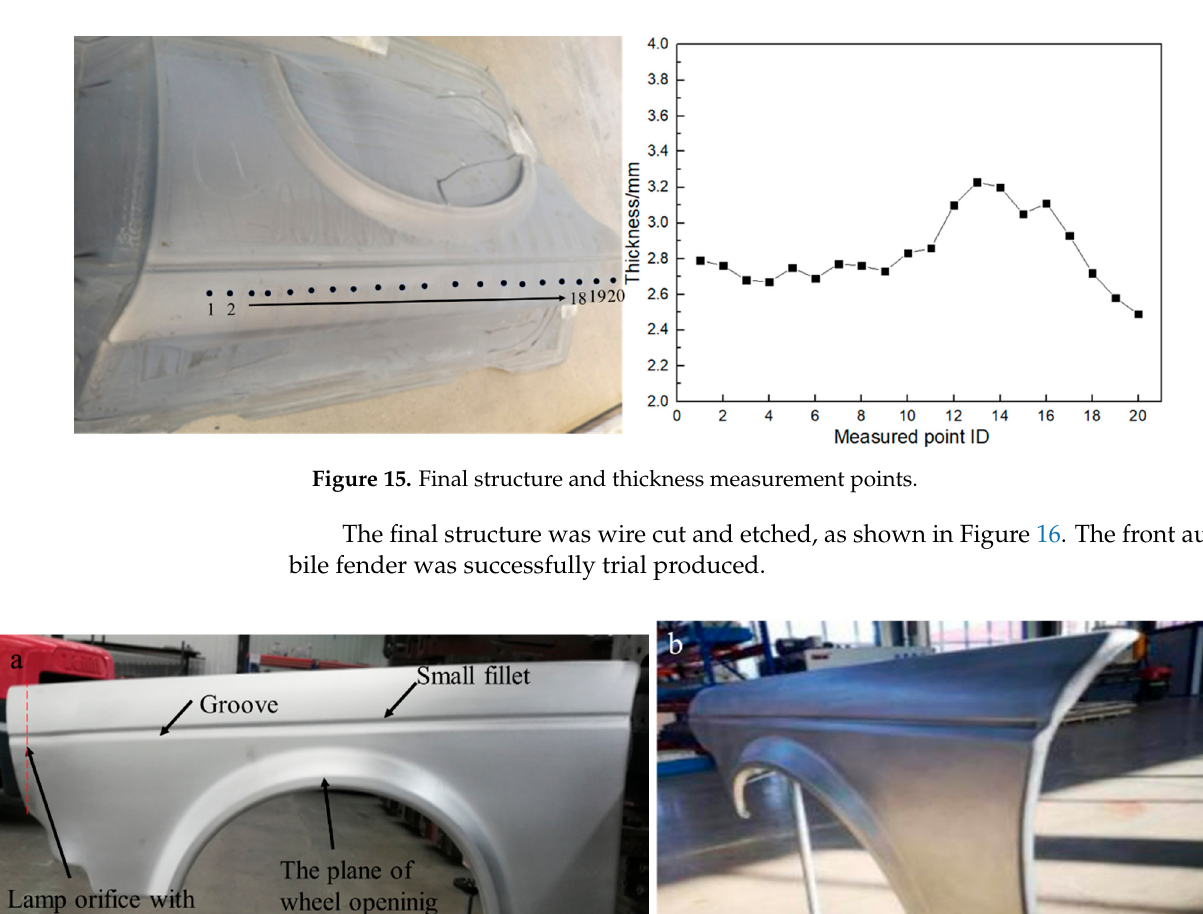
11 of 15 Figure 14. Measurement point ID and thickness: ( a ) preforming structure; ( b ) end; ( c ) longitudinal storage tanks; ( d ) trans ‐ verse storage tanks.